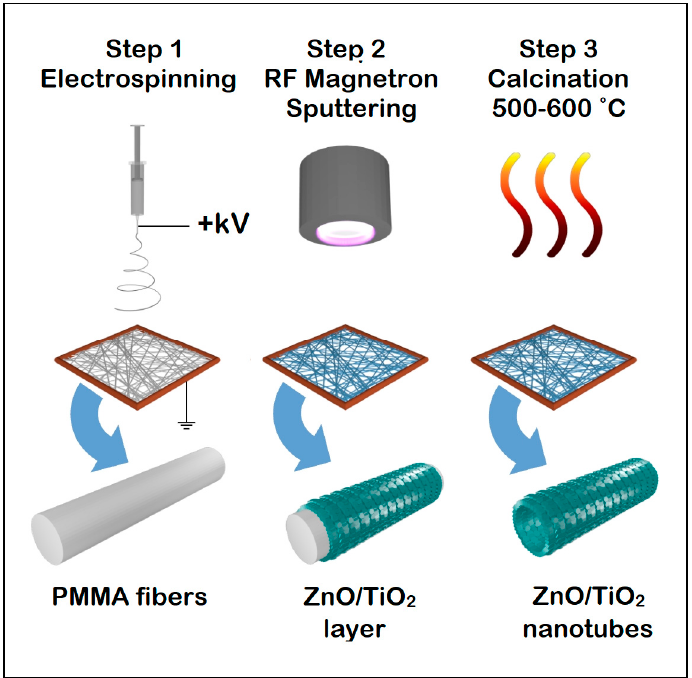
Figure 1. Scheme of the fabrication process of ZnO and TiO 2 nanotubes.